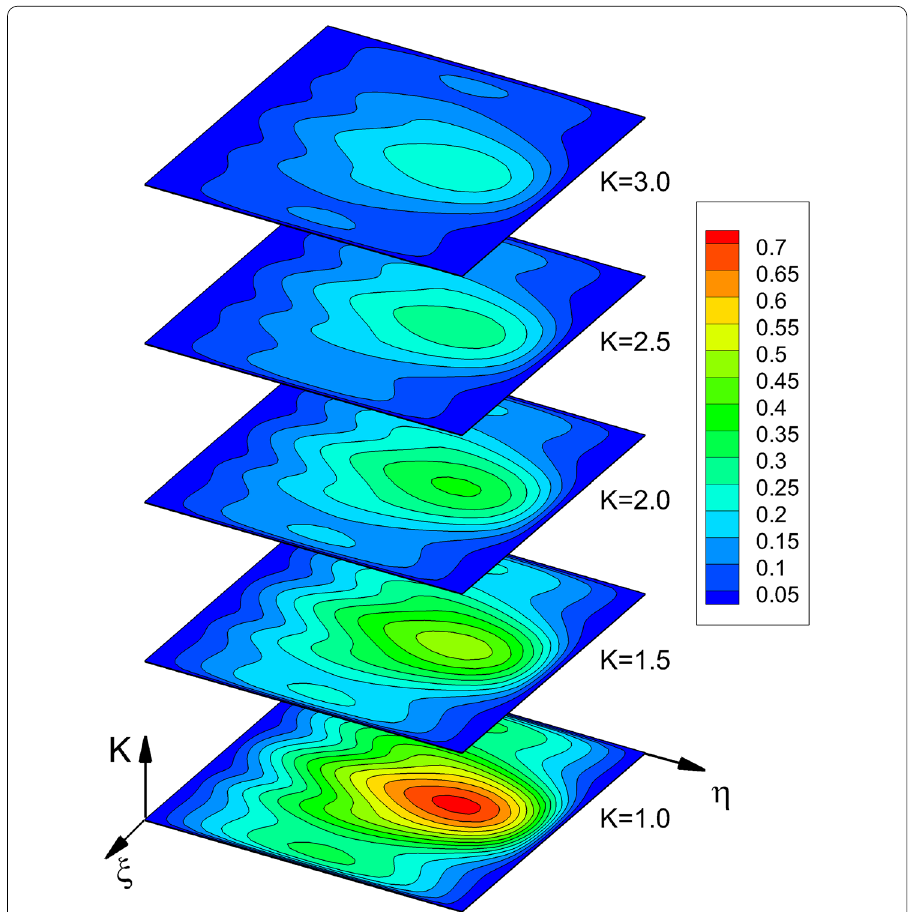
Fig. 15 Temperature distribution for different conductivities in the computational